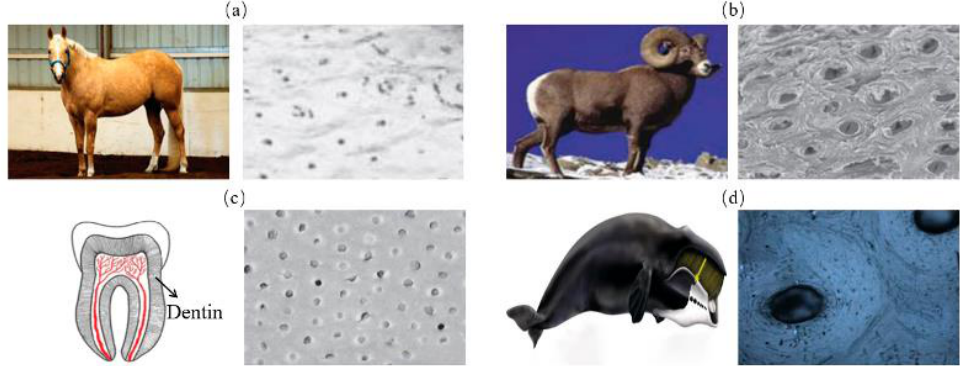
Figure 6. Tubular model in biological organisms. ( a ) horse hooves [38] Copyright©1997, Journal of Experimental Biology ( b ) ram’s horn [39] Copyright© 2010, Acta Biomaterialia ( c ) dentin [40] Copyright©2012, Non-Metallic Biomaterials for Tooth Repair and Replacement ( d ) whale’s baleen [41] Copyright©2019, Advanced Materials .